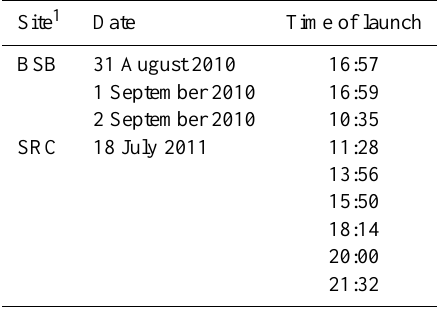
Table 2. Radiosonde launches at BSB and SRC. Times are LT. Site